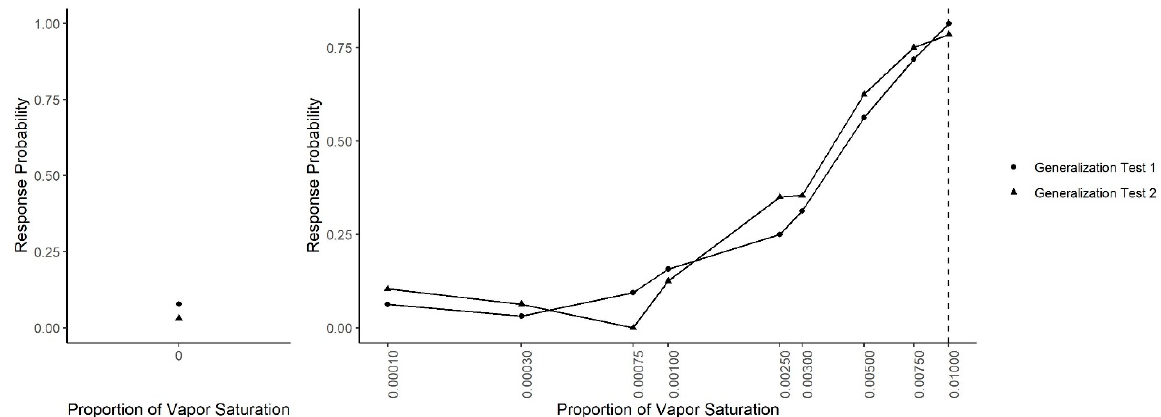
Figure 6. Combined generalization testing. The spontaneous generalization to a range of air dilutions of the trained odorant (0.01; dashed line) for Generalization Test 1 and Generalization Test 2: ( Left ) the response to a clean air stimulus; and ( Right ) the range of concentrations on a log scale.